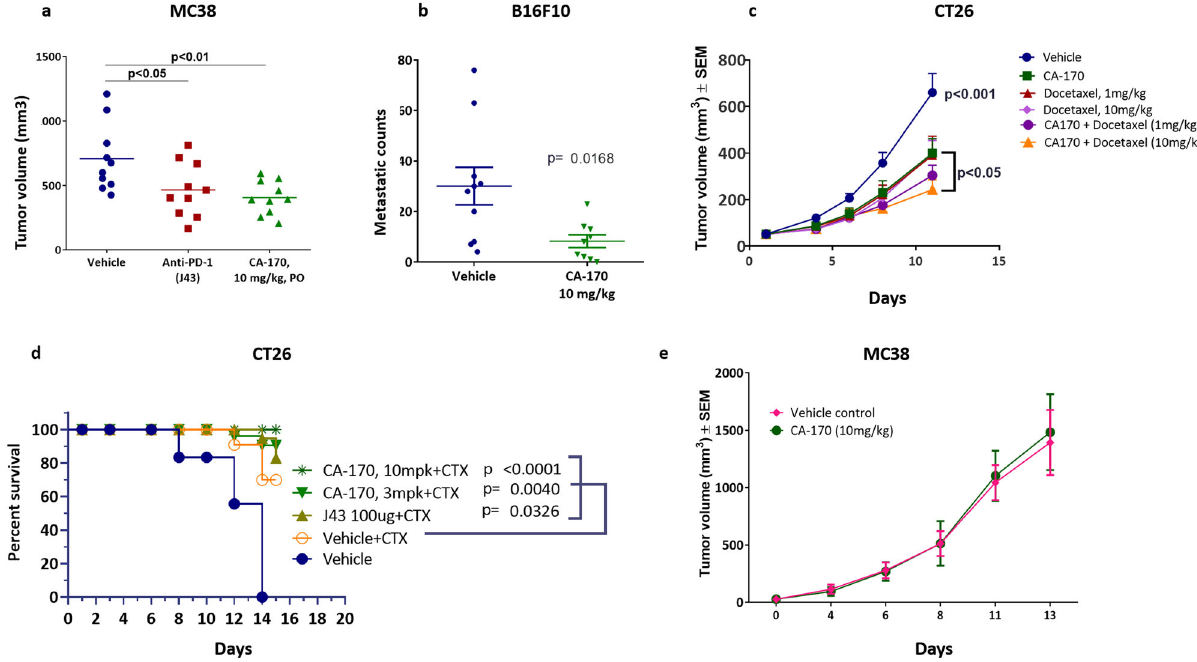
Fig. 5 Anti-tumor ef fi cacy of CA-170 in multiple mouse models. a Ef fi cacy in MC38 model. C57B6 mice were injected with MC38 cells and received CA- 170 at 10 mg/kg/day orally or PD-1 antibody (J43 clone) at 100 µ g/animal/week subcutaneously for a period of 14 days starting from Day 5 ( n = 10). On day 14 of dosing, statistically signi fi cant ef fi cacy of 43% ( p < 0.01) was observed with the group treated with CA-170 at 10 mg/kg, which was comparable to that of PD-1 antibody (tumor growth inhibition of 36%) (J43 clone) ( p < 0.05). b Ef fi cacy in B16F10 metastasis model. B16F10 cells were injected intravenously to C57B6 mice on day 0 and dosed with CA-170 ( n = 9) or a vehicle control ( n = 10) starting from day 1 orally at 10 mg/kg/day dose for a period of 14 days resulted in a 73% reduction in metastatic nodules ( p < 0.01) as compared to a vehicle control. c Ef fi cacy in CT26 model in combination with docetaxel. Balb/c mice were injected with CT26 cells and were treated with CA-170 at 10 mg/kg/day, docetaxel at 1 mg or 10 mg/kg/day or their combination for 12 days ( n = 9). Group treated with CA-170 at 10 mg/kg showed 43% TGI while single agent docetaxel at 1 and 10 mg/kg doses exhibited 44% and 43% TGI, respectively. Combination group of CA-170 at 10 mg/kg and docetaxel at 10 mg/kg showed a statistically signi fi cant TGI of 68% ( p < 0.05). d Ef fi cacy in CT26 model. Balb/c mice were injected with CT26 cells and received CA-170 at 3 or 10 mg/kg/day orally or PD-1 antibody (J43 clone) at 100 µ g/animal/week subcutaneously in combination with a single dose of cyclophosphamide (CTX) on the fi rst day at 100 mg/kg ( n = 9). Statistically signi fi cant survival advantage was observed when vehicle + CTX is compared with PD-1 antibody + CTX ( p < 0.001), CA-170 (3 mg/kg) + CTX ( p < 0.01) or CA-170 (10 mg/kg) + CTX ( p < 0.001) groups. e Ef fi cacy in an immunode fi cient mouse model. Immunode fi cient SCID beige mice were injected with MC-38 cells and animals received either a vehicle control or CA-170 (10 mg/kg/day) treatments for 14 days ( n = 11) and there was no difference in the tumor volumes of the two groups. Student ’ s t test was used to determine the statistical signi fi cance in all in vivo experiments and the statistical signi fi cance is denoted as * p < 0.05, ** p < 0.01, *** p < 0.001, **** p <